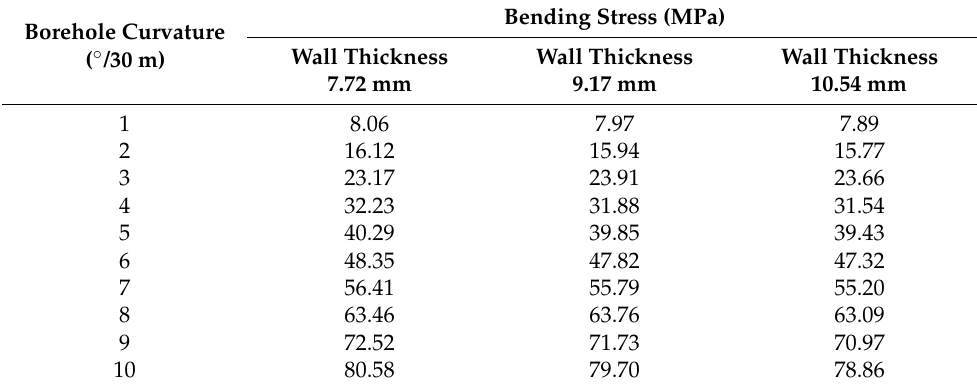
Table 4. Casing bending stress under different borehole curvature.